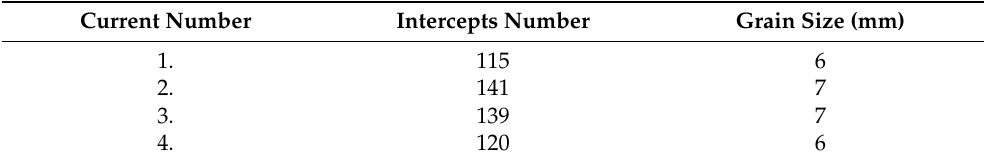
Table 5. The results were obtained after determining the austenitic grain index for the 10CrMo9-10 sample